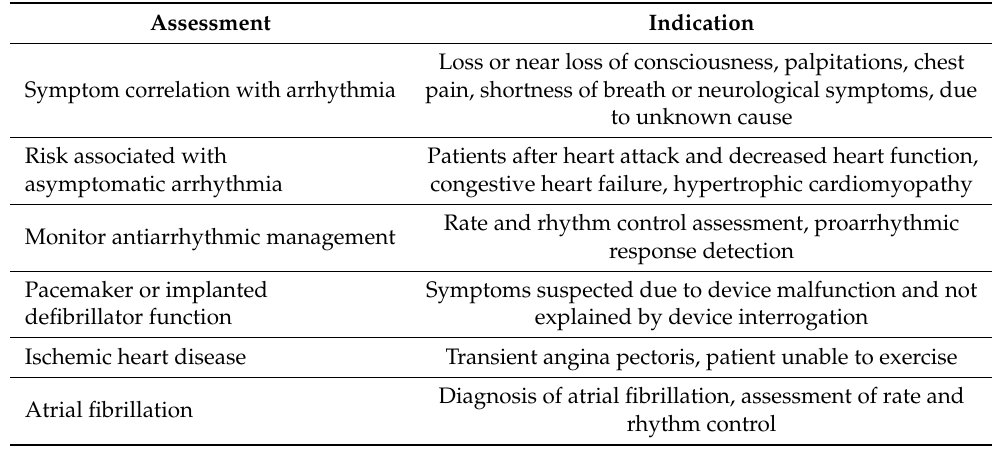
Table 8. Overview of common indications for heart rate/rhythm monitoring in clinical